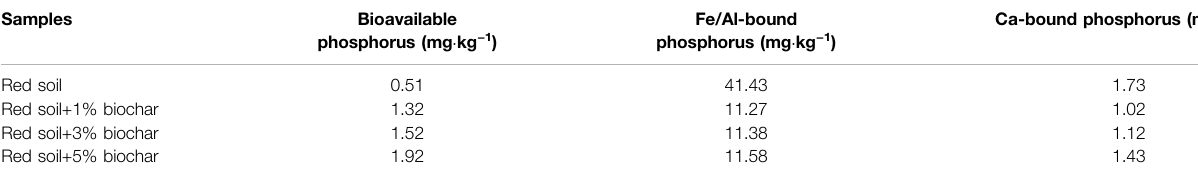
TABLE 1 | Sequential extraction of P from the pure and biochar-amended red soils. Samples